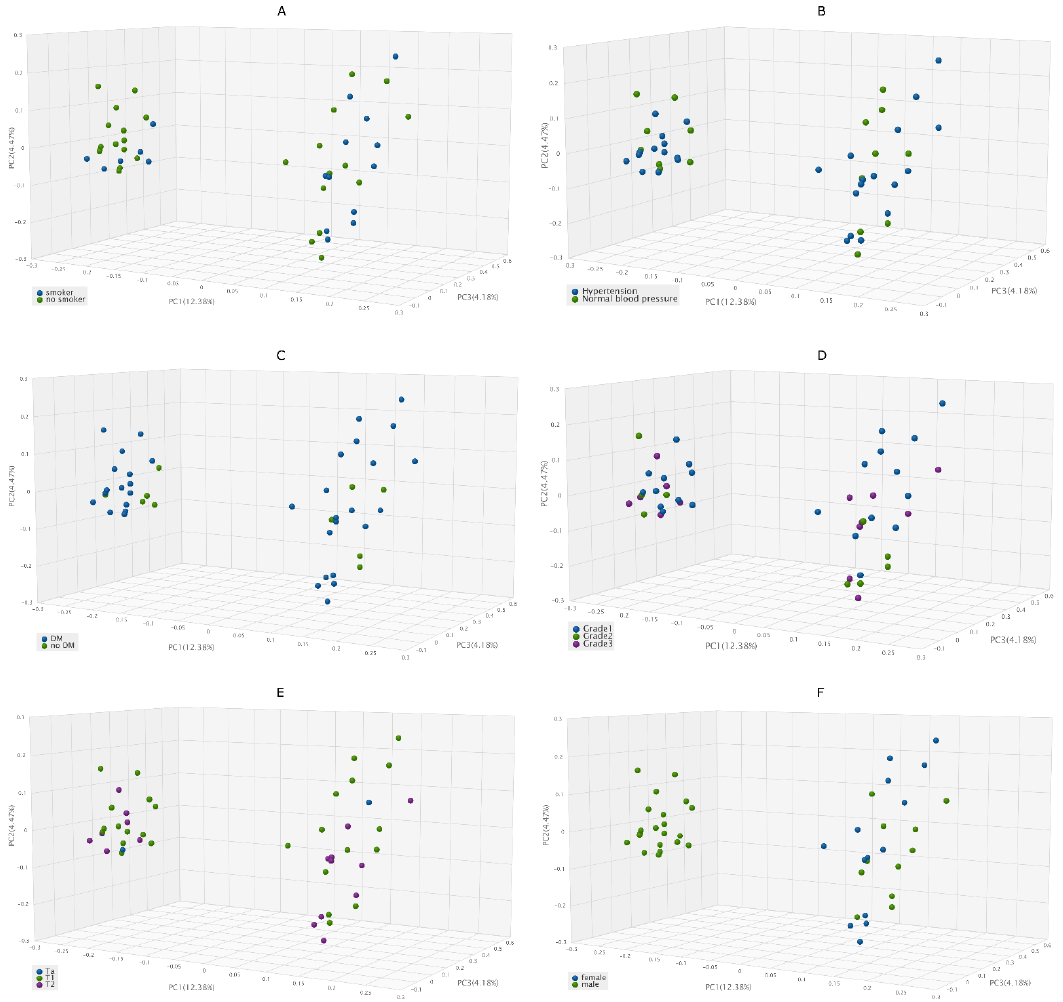
Figure 3. Relationship between characteristics of BC patients and microbiome beta diversity The Jaccard beta diversity graph for tumor samples shows two well-separated clusters, but the following properties alone do not show any correlation with cluster classification, ( A ) smoking habit, ( B ) hy- pertension, ( C ) diabetes mellitus, ( D ) grade of the cancer, ( E ) stage of the cancer. ( F ) There is a sig- nificant difference in the classification of female and male tissue samples into microbiome clusters . Compared to the median ΔCt value of PH samples — considered as a control group — the RQs of HBD1, HBD2 and HBD3 mRNA of PH patients and BC patients showed curves that were not normally distributed. Furthermore, 59% of samples from BC patients ex- pressed higher amounts of HBD1. Additionally, higher HBD2 or HBD3 expression was detected in 74% or 50% of BC samples, respectively. Compared to the median values of controls, the largest differences in gene expression values in the BC group were 7-fold for HBD1, 9-fold for HBD2 and 45-fold for HBD3, respectively. Defensin mRNA expression RQ values and the amounts of HBDs measured in urine samples are shown in Figure 4A – E. The median amount of HBD1 was 12.59 ng/mL (IQR: